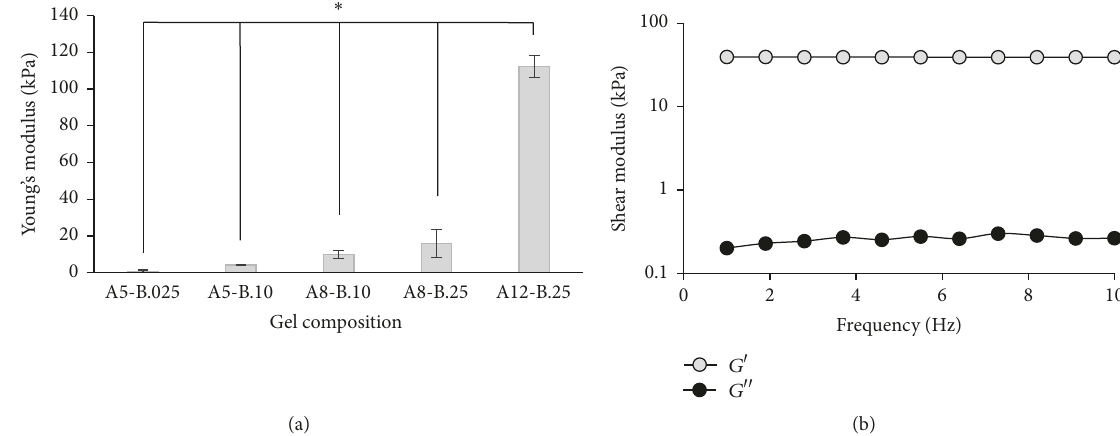
Figure 1: (a) Young’s modulus as a function of gel composition for TEMED-crosslinked PAA hydrogels. (b) Representative shear stress as a function of frequency plot for A12-B0.25 PA hydrogel. Asterisks designate significant differences for 𝑝 < 0.05 , 𝑛 = 3